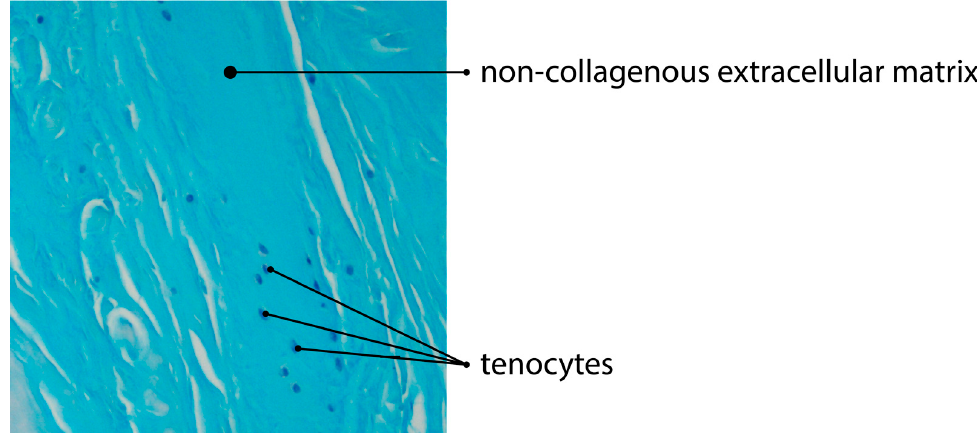
Figure 3. Alcian blue staining of tendinous tissue showing impaired angiogenesis due to deposition of non-collagenous ECM (magnification of the objective: 20 × ). Koehler et al., using a 3D angiogenesis model, demonstrated that glycosaminoglycan accumulation impaired the biological activity of VEGF [72]. Furthermore, Cheng et al. re- vealed that non-collagenous components of the ECM inhibit VEGF receptor signaling [73]. VEGF levels are elevated after the inflammatory phase, during the formation and remod- eling phases [5]. Its main role is the stimulation of the angiogenesis process [74]. The neo- vascularization process is crucial in the tendon healing process. On the other hand, it is also an important component of the degeneration of tendinous tissue, when the regener- ation is incomplete and insufficient. 4. Conclusions The microscopic analysis of the tendinous tissue features is often challenging and difficult. The assessment using the Bonar system is the most commonly used in tendon pathology. According to the literature, H&E staining with additional Alcian Blue seems to provide sufficient material for the observer. Moreover, two investigators experienced in musculoskeletal pathology ensure a satisfying microscopic evaluation of tendinopathy. The control, due to similar and typical alterations in tendinous tissue, is not necessary. Neovascularization plays an ambiguous role in tendon disorders. Thus, this uncertain variable should be reconsidered and updated in tendinopathy scoring systems. Author Contributions: Conceptualization, Ł .J., M.G. and D.G.; methodology, Ł .J. and M.G.; soft- ware, M.Z.; validation, D.G., A.K.-W. and W.Z.; formal analysis, D.G. and M.G.; investigation, M.G., M.Z. and Ł .J.; resources, M.G. and M.Z.; data curation, M.G. and Ł .J.; writing—original draft prep- aration, M.G., W.Z. and Ł .J.; writing—review and editing, D.G.; visualization, M.Z.; supervision, D.G., A.K.-W. and M.G.; project administration, M.Z. and M.G. All authors have read and agreed to the published version of the manuscript. Funding: This research received no external funding. Institutional Review Board Statement: Not applicable Informed Consent Statement: Not applicable Conflicts of Interest: The authors declare no conflict of interest. References